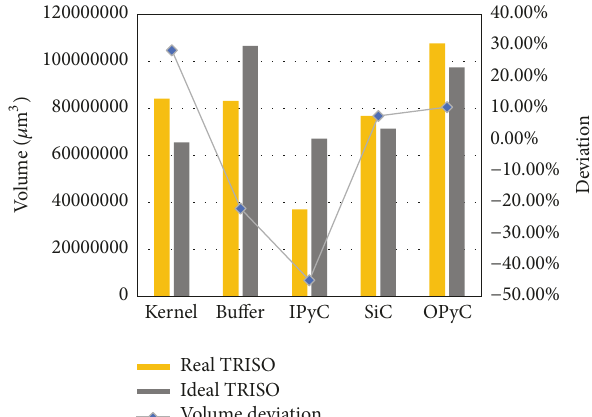
Figure 5: Measured volume and ideal spherical volume of TRISO.